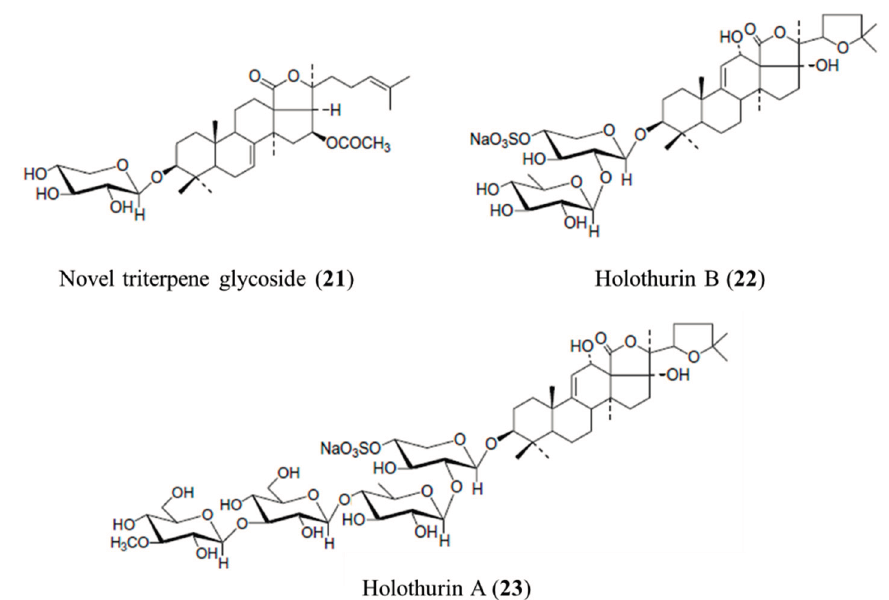
Figure 6. The novel triterpene glycoside ( 21 ), holothurin B ( 22 ) and holothurin A ( 23 ) isolated from sea cucumber Actinopyga lecanora [60].